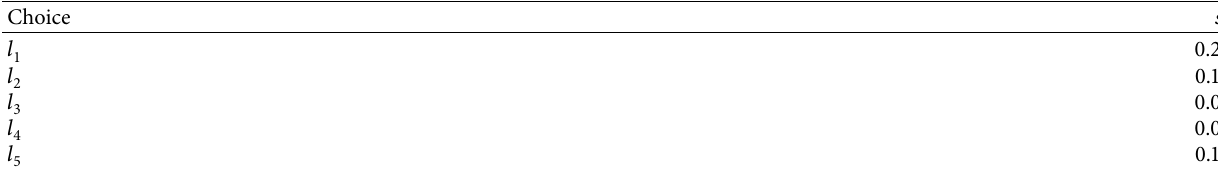
Table 5: Values of P m FWA ( O